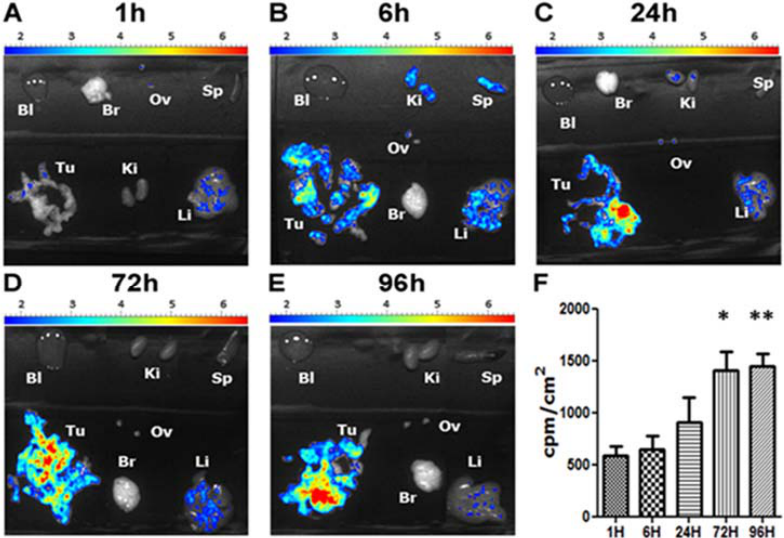
Figure 4. Passive targeting of diffuse peritoneal tumors by NPs 22 . ( A–E ) Evolution of fluorescence distribution over time using isolated organs imaging. ( F ) Quantification of NPs accumulation in tissues over time by measuring fluorescence. * p < 0.05 and ** p < 0.01. Bl: Blood, Br: Brain, Ov: Ovaries, Sp: Spleen, Tu: Tumor, Ki: Kidneys, and Li:b Liver.